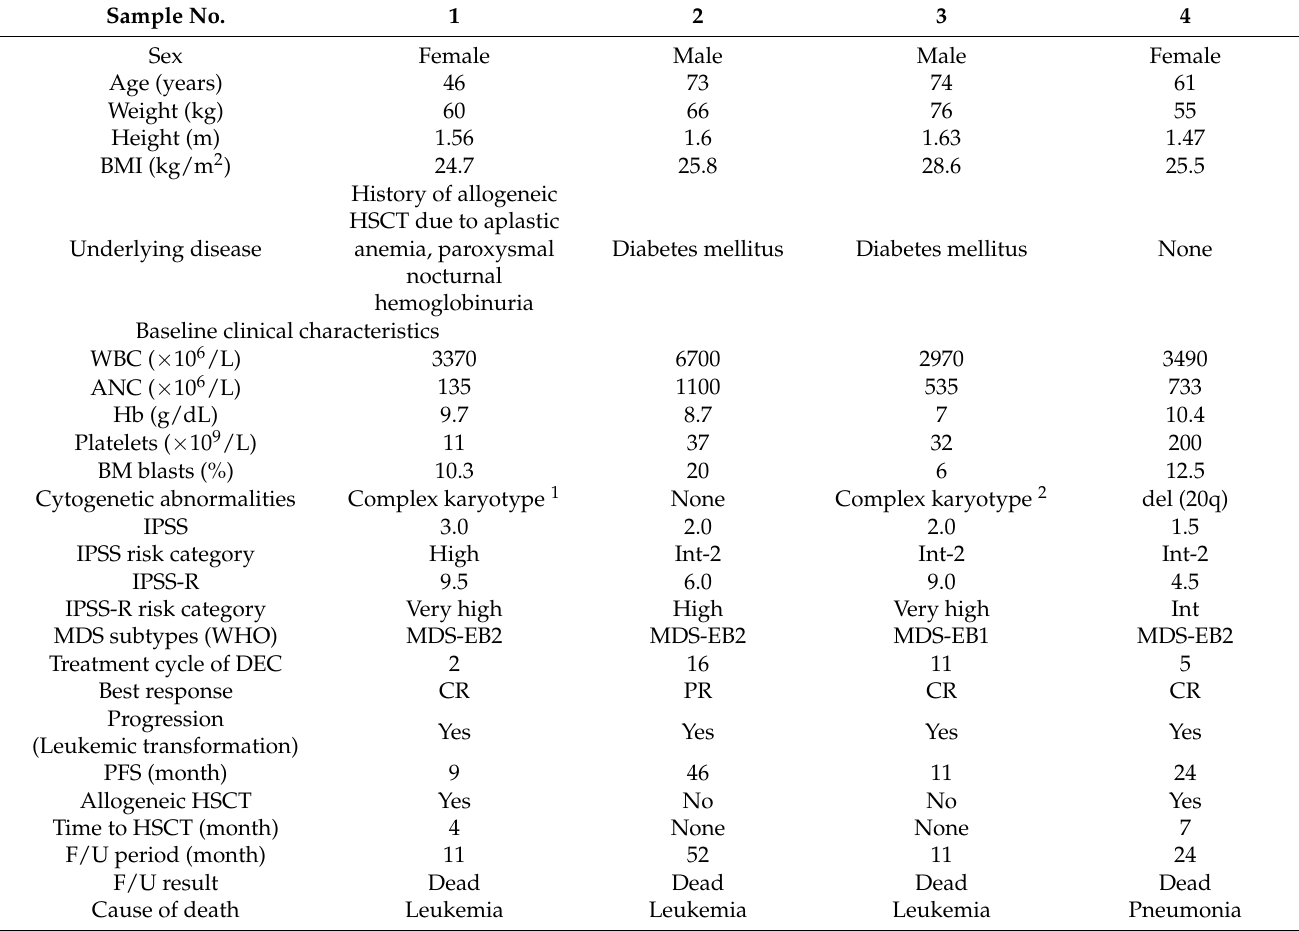
Table 2. Clinical characteristics of the MDS patients treated with